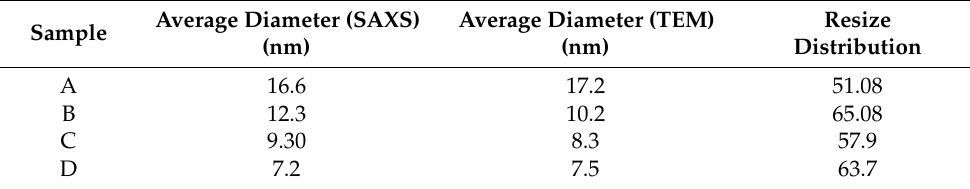
Figure 7. Size distribution plot for the AMF samples (A, B, C, and D) modeled from the SAXS measurements assuming Gaussian or log-normal distribution. Table 2. Comparison of the average size obtained from the SAXS and TEM for the AMF samples A, B, C, and